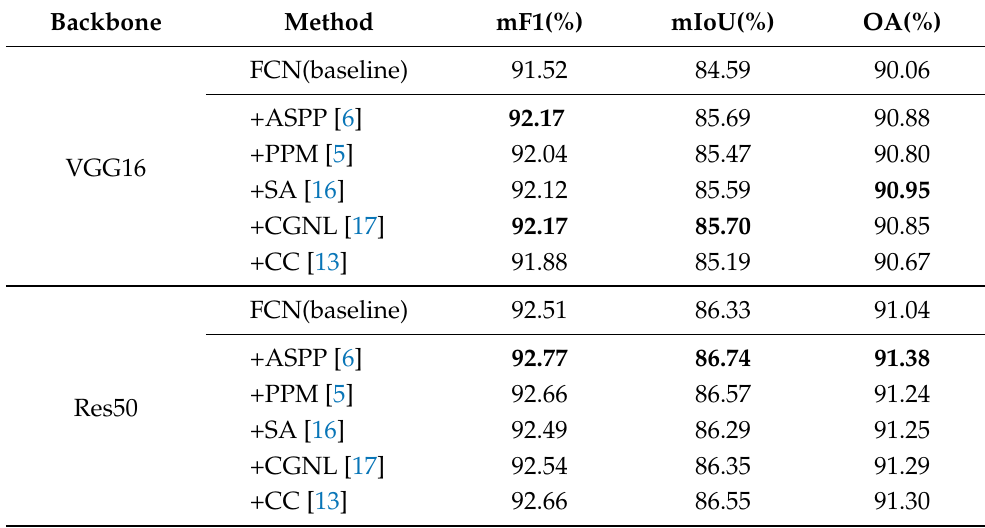
Table 9. Comparison of the performance with different context aggregation modules for Pots- dam